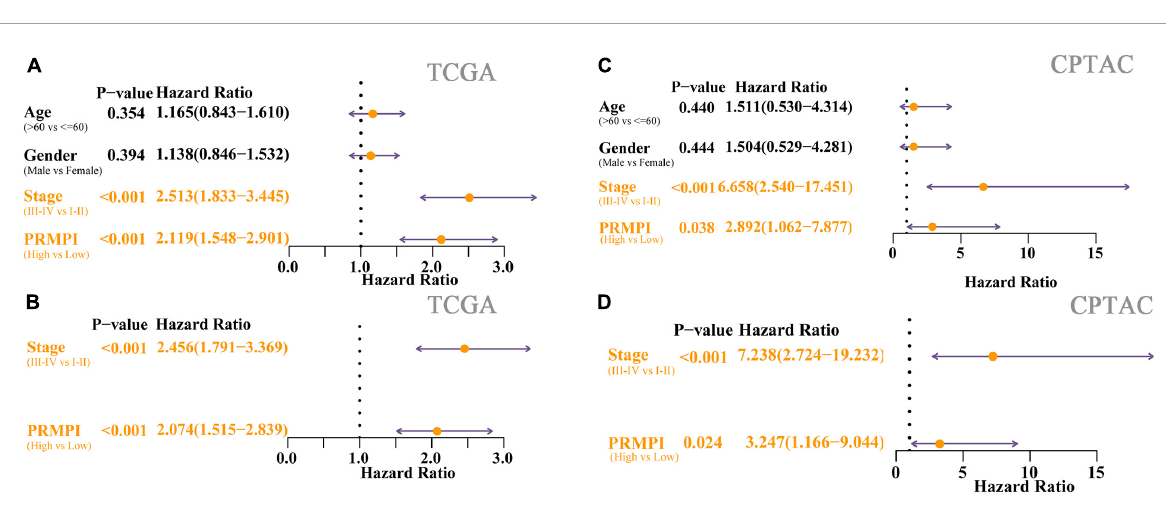
FIGURE5 Cox regression analyses for the clinicopathological factors and PRMPI scores. (A) Univariate Cox regression analysis of clinicopathological and the PRMPI score for TCGA cohort. (B) Multivariate Cox regression analysis of the factors that have statistical differences in the univariate analysis ( p -value < 0.05) TCGA cohort. (C) Univariate Cox regression for the CPTAC cohort. (D) Multivariate Cox regression analysis for the CPTAC cohort. OS, overall survival; PRMPI, pyroptosis-related mRNA prognostic